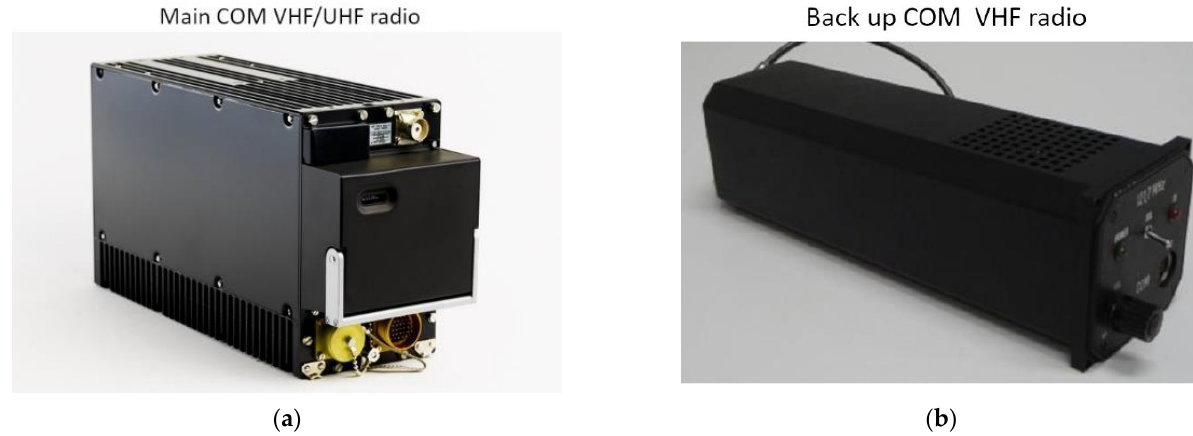
Figure 4. Shielding of radio frequency (RF) blocks in LUN-3520 ( a ) and LUN-3524 ( b )